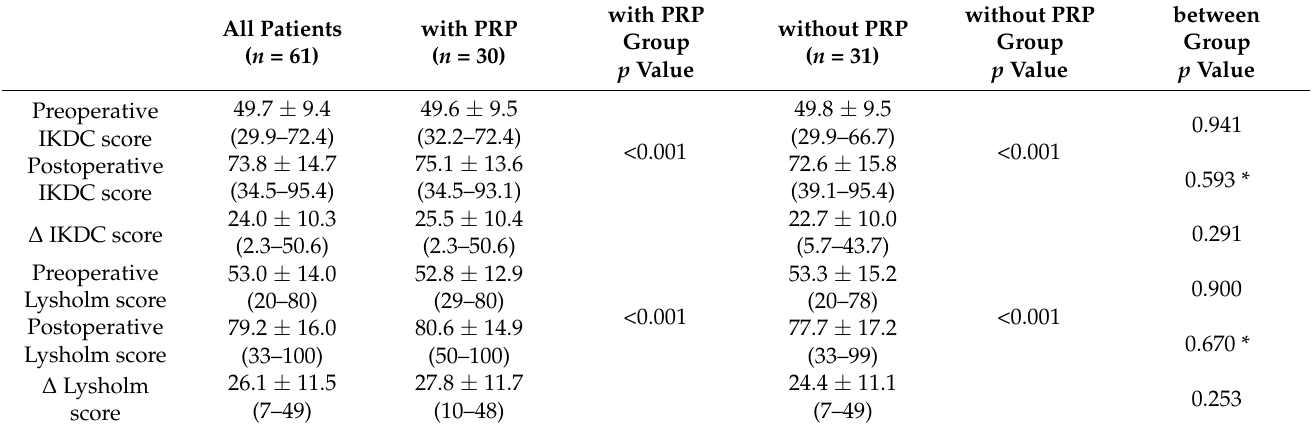
Table 4. Functional